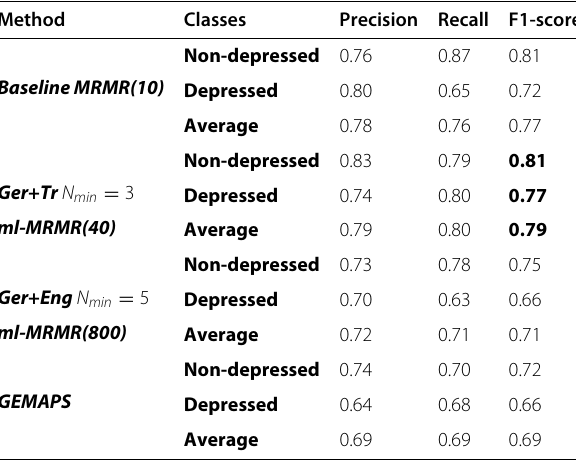
Table 9 Classification results for German Task. ml-MRMR was used with RCR. There are 56 non-depressed and 44 depressed subjects in the database. Best results are shown in bold. Number of selected features are shown in parenthesis for each case. The improvements are not statistically significant with respect to baseline